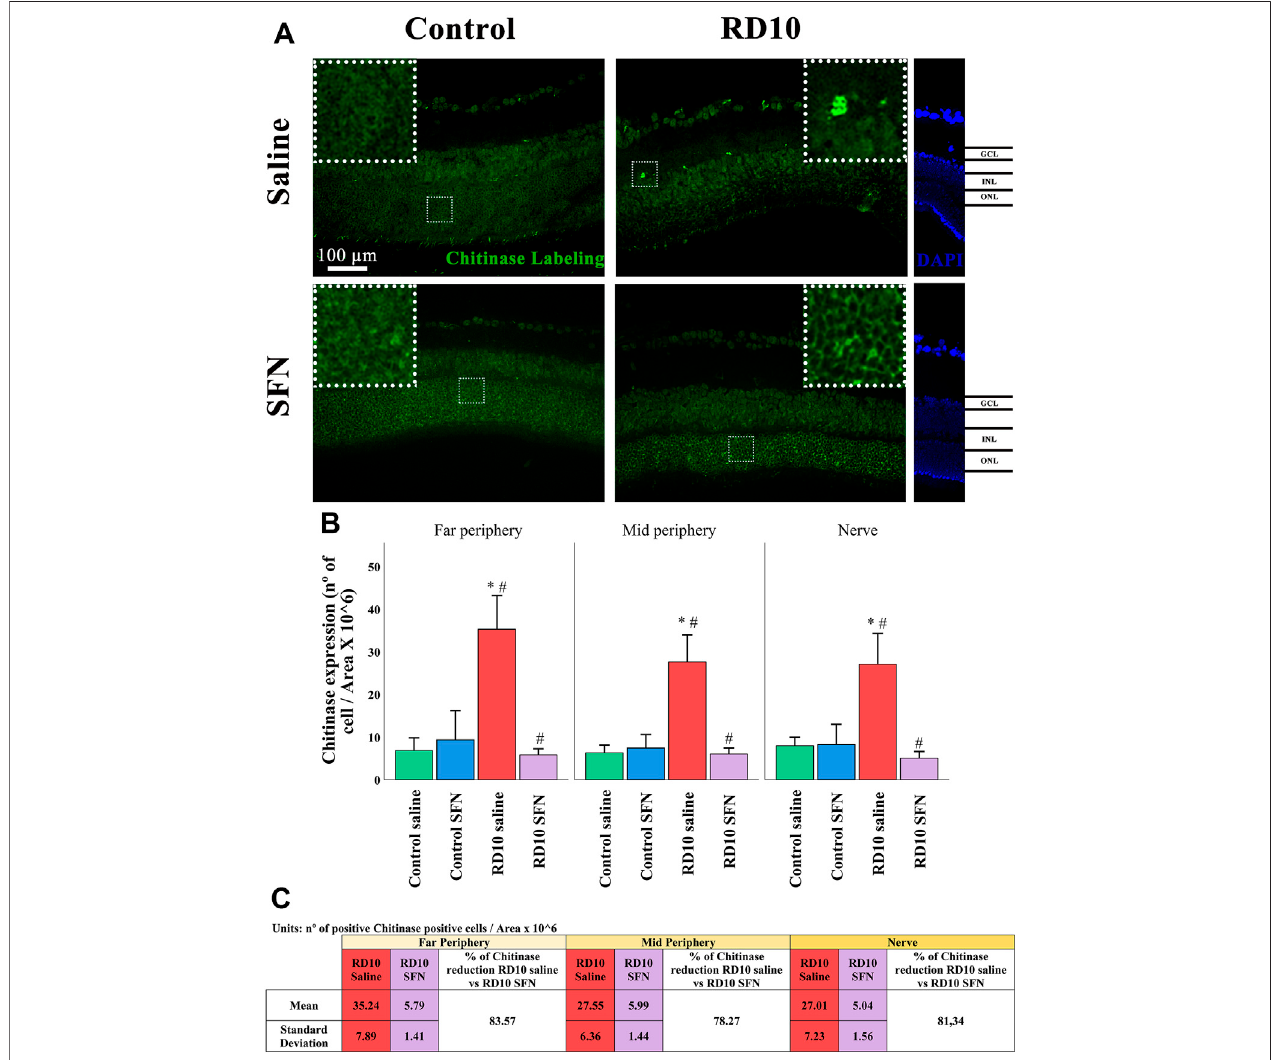
FIGURE 11 | Chitinase 3-like protein (YM1) expression assessment. (A) Nerve region images of chitinase immuno fl uorescence of the different groups in the experiment;whitearrowspointoutthepositivemark. (B) Thenumberofchitinase-positivecellswasdividedperareaandmultipliedby10 6 .*DifferencesbetweenControl Salinevs.RD10SalineorControlSFNvs.RD10SFN( p -value < 0.05).#DifferencesbetweenRD10Salinevs.RD10SFN( p -value < 0.05). (C) EffectofSFNonRD10mice chitinase mark expressed by the mean and standard deviation of the RD10 groups, and percentage reduction of RD10 Saline vs. RD10